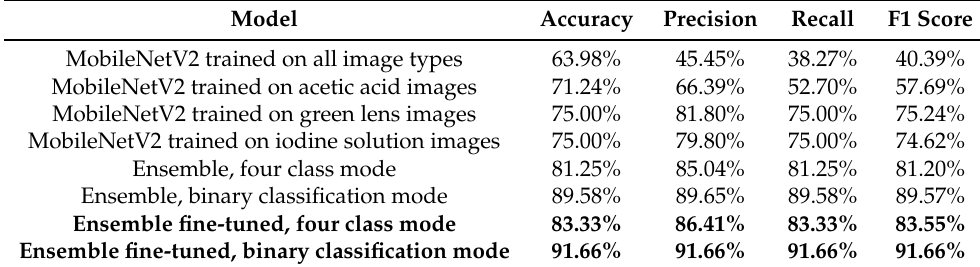
Table 6. Results of the network trained on all images at once, of networks specialized on individual image types and of the ensemble in both four class and binary mode. For the ensemble, we provide a simpler version and another one fine-tuned through training with a smaller learning rate. Where we mention MobileNetV2, we refer to the model modified as described in Section